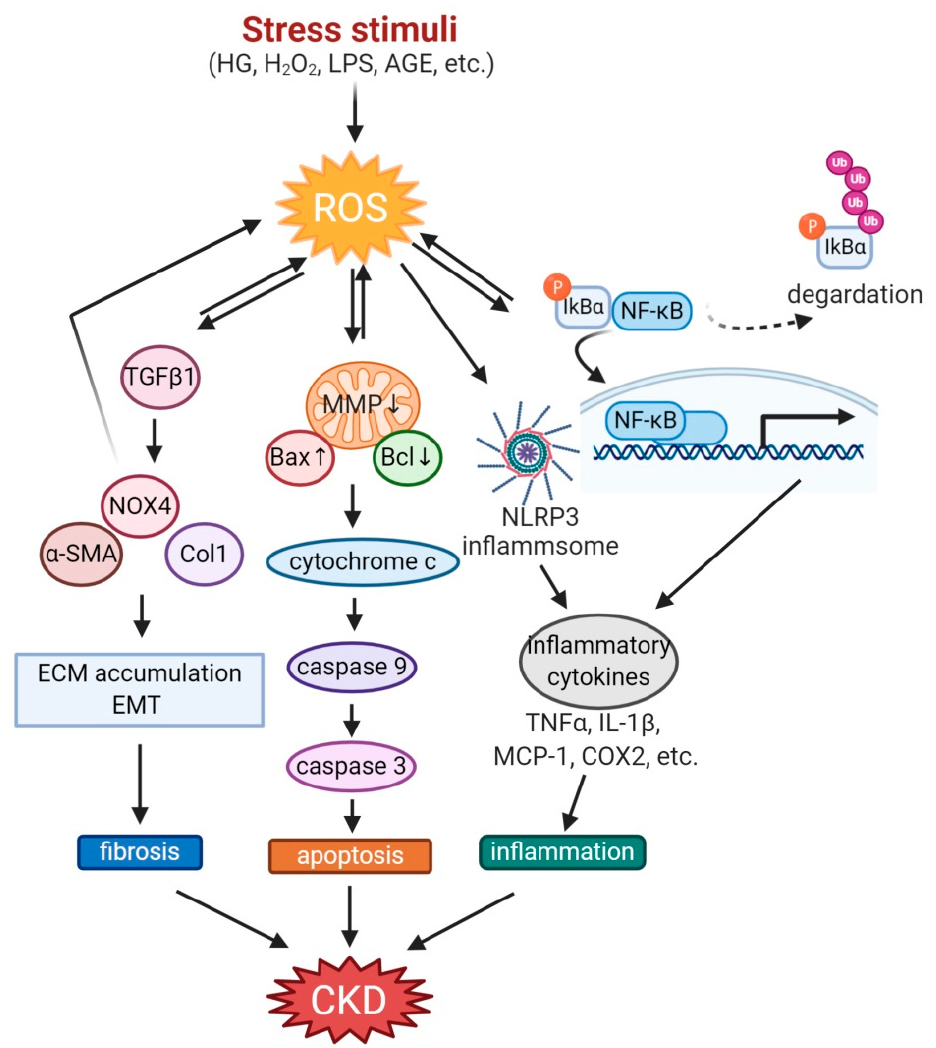
Figure 1. Mechanisms involved in the pathogenesis of OS in CKD. Stress stimuli such as high glucose, H 2 O 2 , and AGE generate ROS in the kidney. The higher ROS increases TGF β activation, causing kidney fibrosis through the accumulation of ECM and EMT. ROS also decreases MMP and regulates Bax/Bcl2 in mitochondria to activate caspase3, resulting in apoptosis. Not only nuclear localization of NF-kB through degradation of phosphorylated IkB α but also NLRP3 inflammasome activation induces inflammation with inflammatory cytokines secretion. These ROS-induced pathophysiologic conditions exacerbate CKD. AGE, advanced glycation end products; CKD, chronic kidney disease; COX2, cyclooxygenase 2; ECM, extracellular matrix; EMT, epithelial-to-mesenchymal transition; HG, high glucose; LPS, lipopolysaccharide; MCP-1, monocyte chemoattractant protein-1; MMP, mitochondrial membrane permeability; NLRP3, NLR family pyrin domain containing 3; ROS, reactive oxygen species; TNF α , tumor necrosis factor α ; TGF β , transforming growth factor β